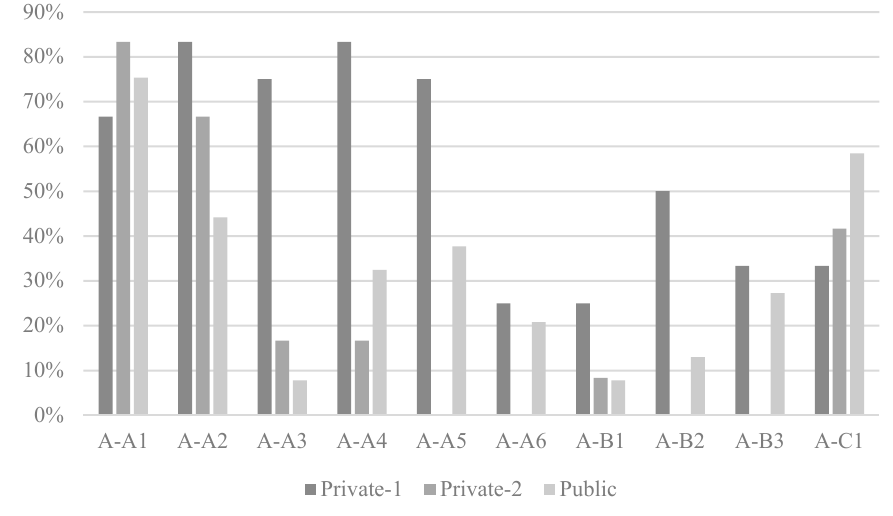
Figure 5. Relative contribution of each type of anomaly for the degradation of VLF in each type of inspected health facility.